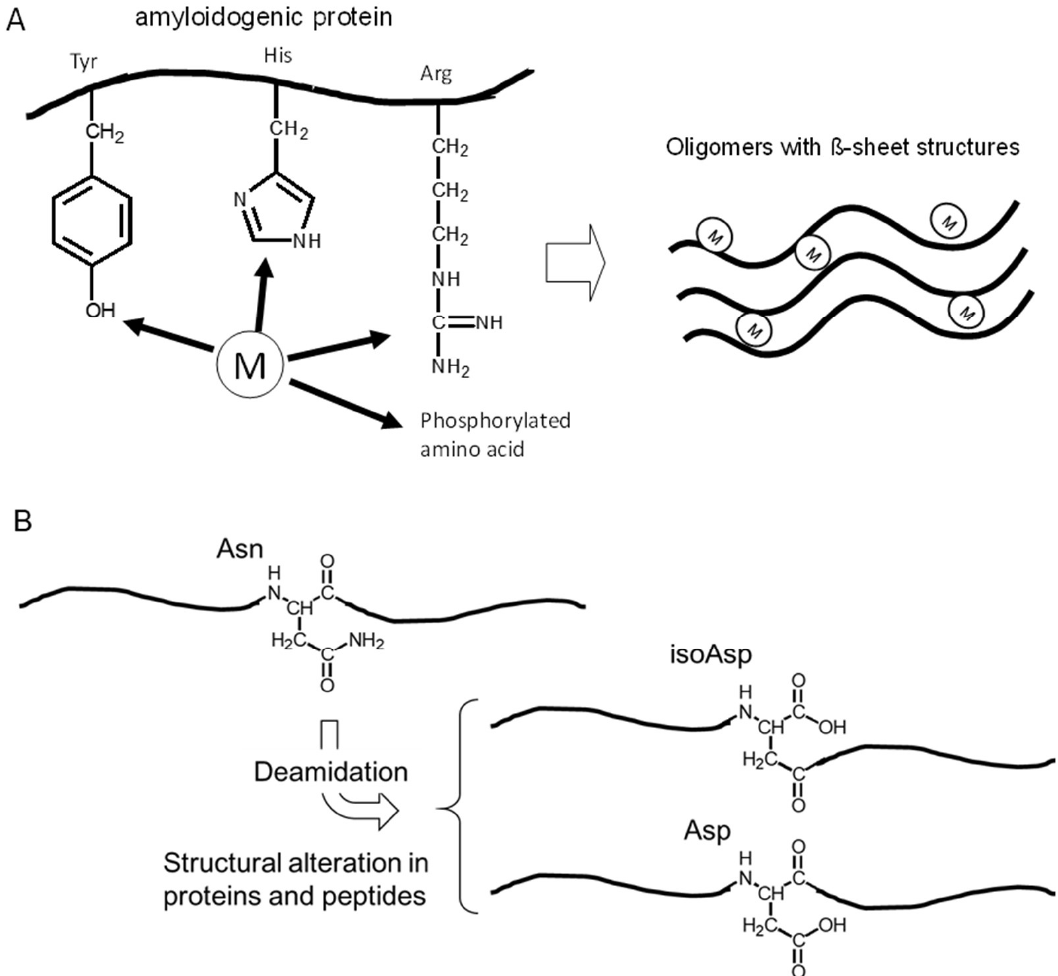
Figure 1. Metal binding and Asn deamidation in proteins. ( A ) Trace elements act as cross-linkers of amyloidogenic proteins. M stands for metal. ( B ) Deamidation of Asn residue affects the fibril formation by structural alteration of the neighboring Asn residue.